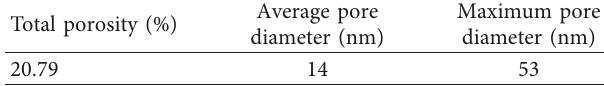
Figure 4: SEM images under different magnifications: (a) 2000 Table 3: Critical parameters of pores.